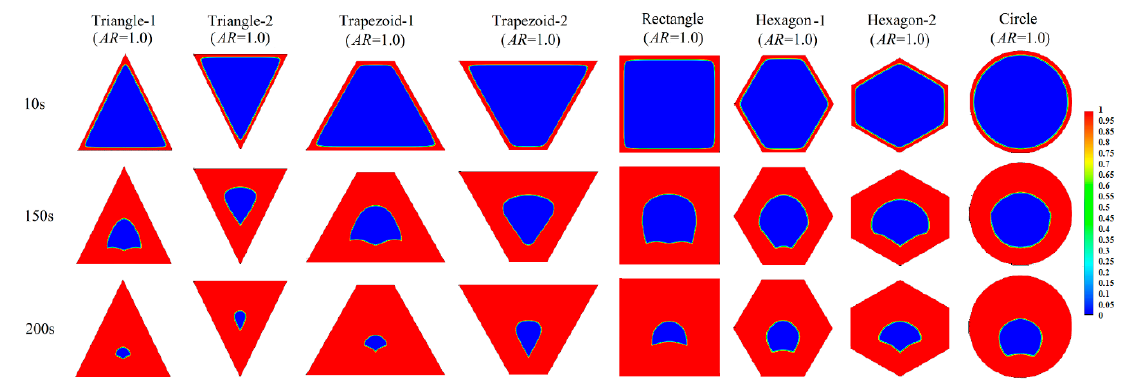
Figure 5. Liquid fraction contours at an initial, intermediate, and final melting time in triangular, trapezoidal, square, hexagonal, and circular cells ( AR = 1.0) at Ra = 3.095 × 10 5 ( A = 100 mm 2 ).